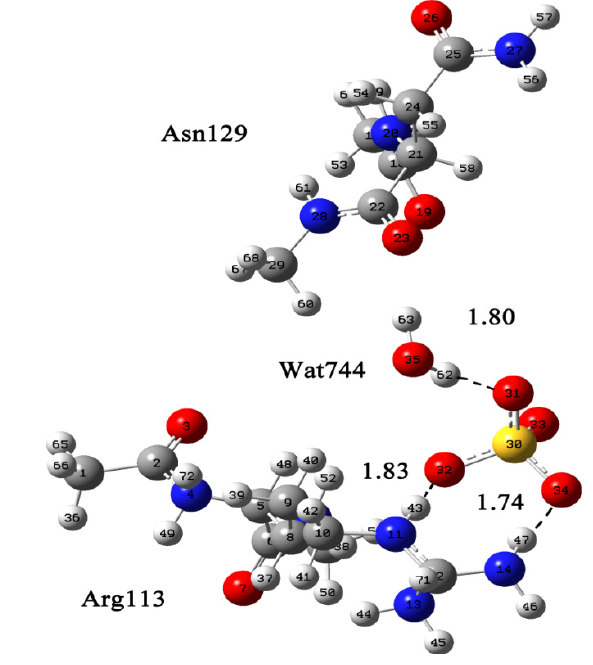
Figure 3. The calculated Arg · SO 42 · H O · Asn supermolecular system displayed in Gaussian 2 View. Arg113, Asn129, Wat744, and one SO 42 − . The coordinates of Arg113, Asn129, Wat744, and one SO 42 − were taken from Protein Data Bank [23].